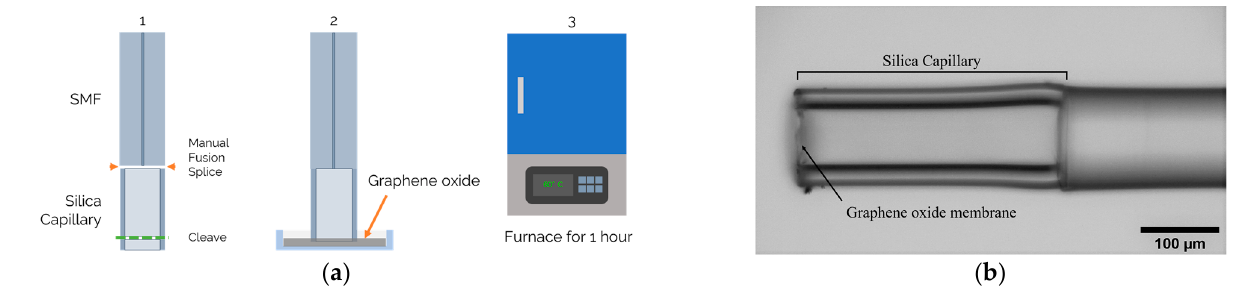
Figure 1. ( a ) Sensor fabrication process: silica capillary fusion spliced to the single mode fiber (SMF) and cleaved to the desired length; graphene oxide (GO) dip coating; and finally, the sensor is placed on a furnace for 1 hour at 60 °C ; ( b ) microscope photograph of the sensing structure with the GO diaphragm at the tip of the silica capillary.